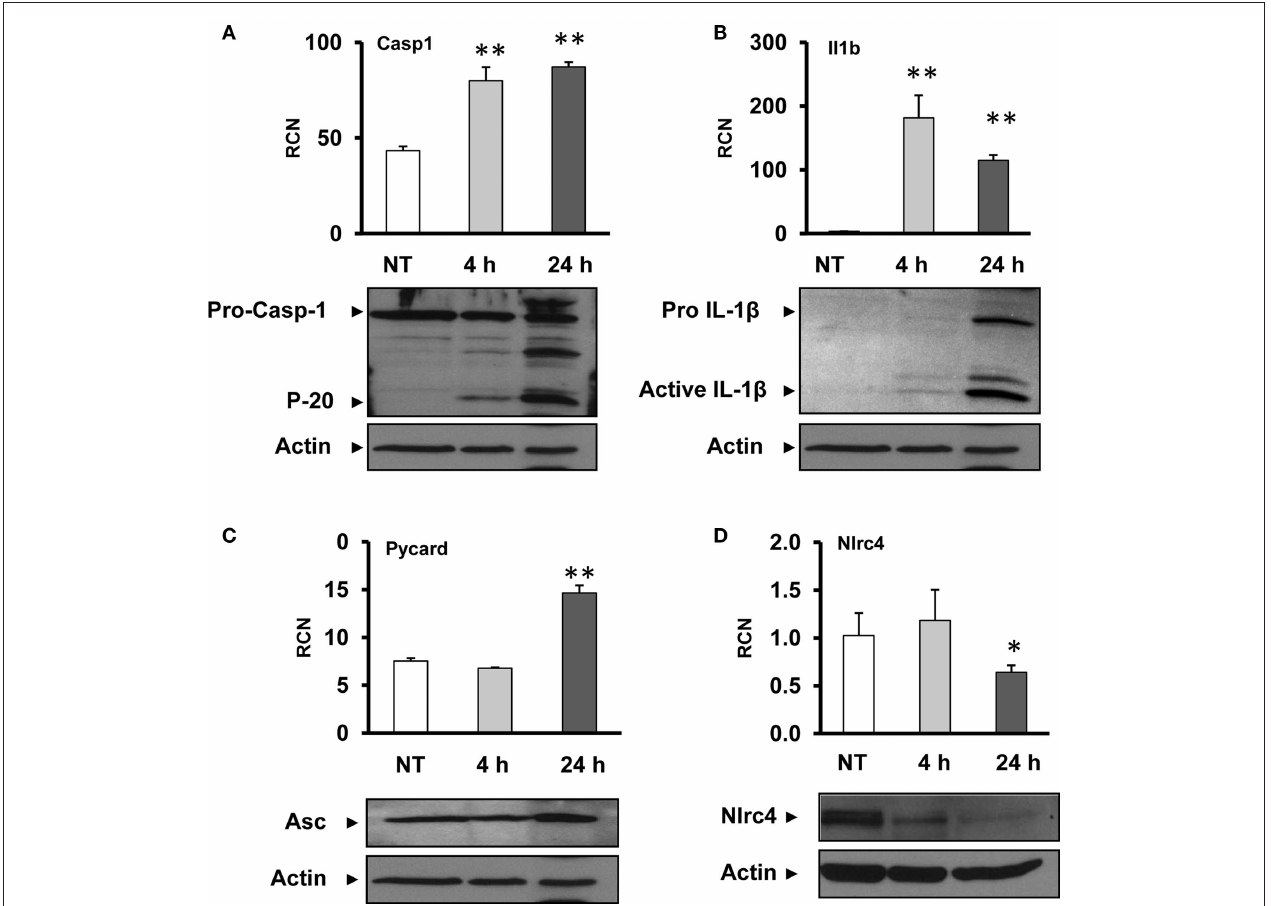
Nlrc4 (Ipaf) were then assessed on both mRNA (upper panels) and protein levels (lower panels) using RT-PCR and Western blots, respectively. The data of RT-PCR are displayed as mean relative copy numbers (RCN) ± SD of three independent experiments. * P ≤ 0.05, ** P ≤ 0.01. Actin was used as loading